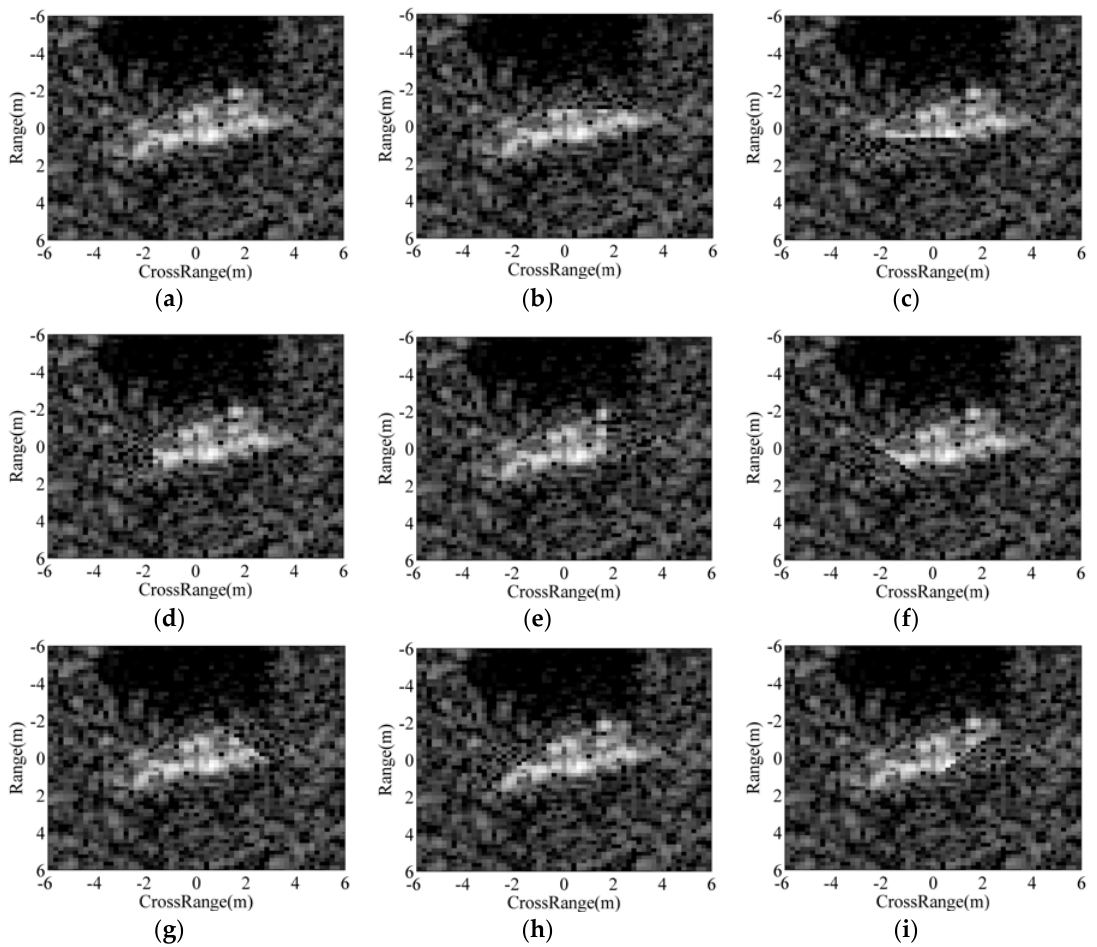
Figure 12. Twenty percent occluded images from different directions. ( a ) Original image, ( b ) direction 1, ( c ) direction 2, ( d ) direction 3, ( e ) direction 4, ( f ) direction 5, ( g ) direction 6, ( h ) direction 7, ( i ) direction 8.